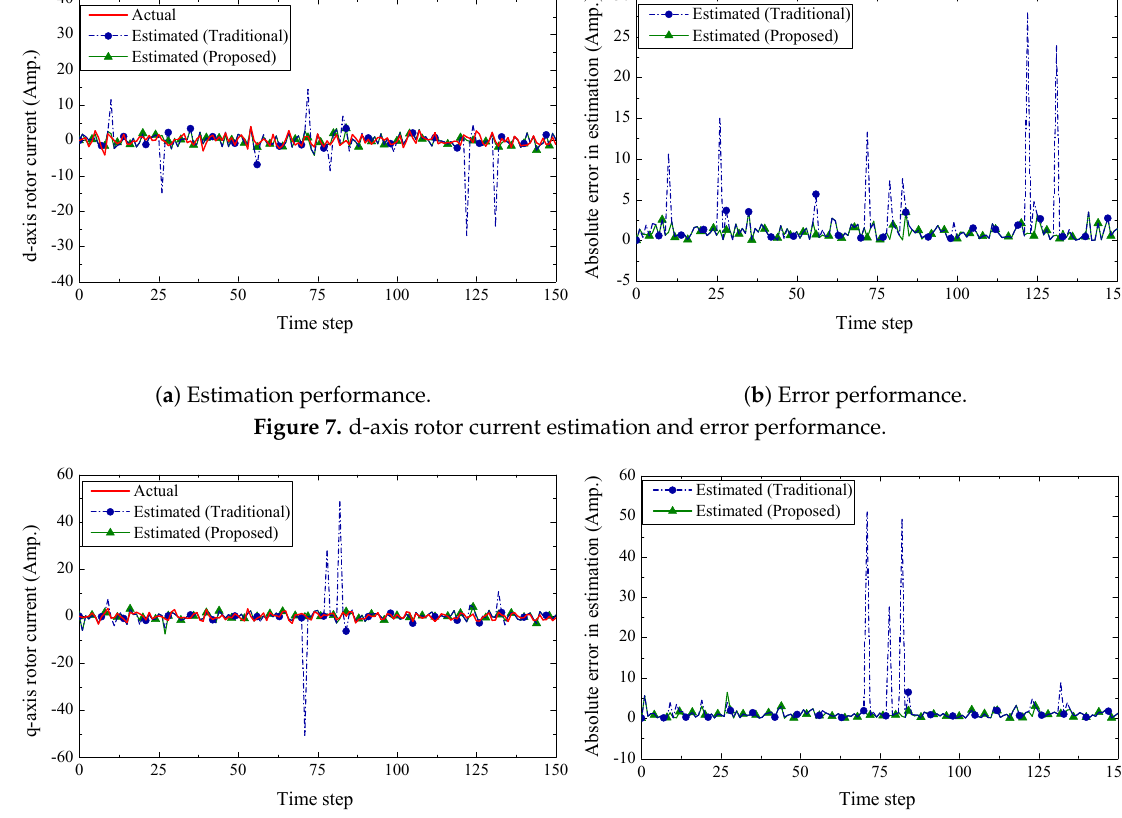
Figure 8. q-axis rotor current estimation and error performance.